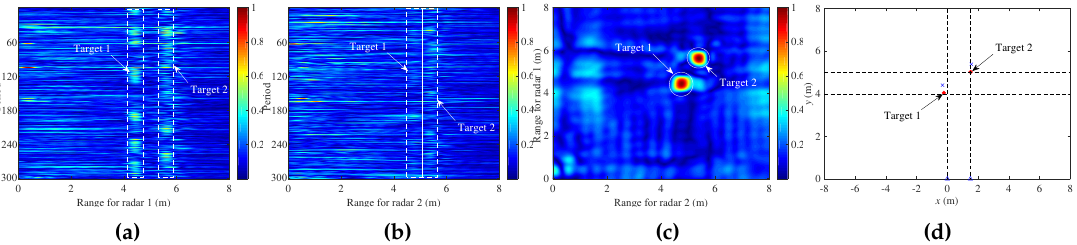
Figure 22. Results of Experiment 4.3: ( a ) range profile plane for Radar 1; ( b ) range profile plane for Radar 2; ( c ) cross-correlation image; and ( d ) localization